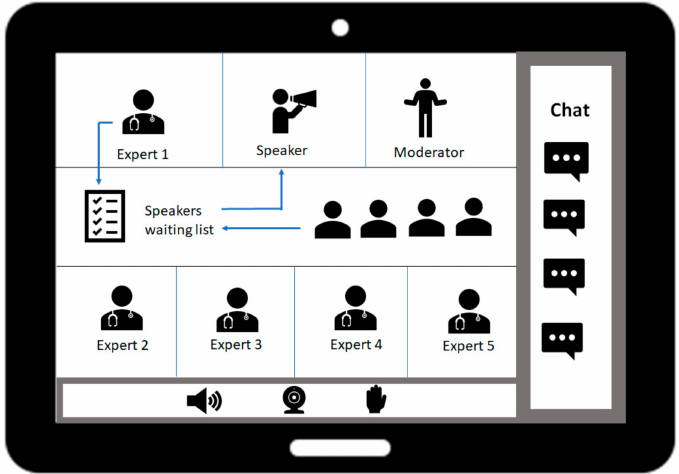
Figure 1. Virtual fishbowl discussion (in accordance with Muehlensiepen et al.